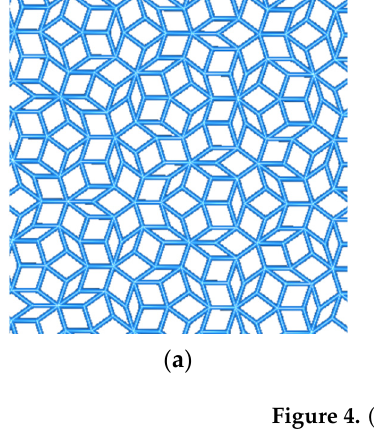
( b ) Figure 5. ( a ) Diffraction pattern of the Penrose tiling with monoatomic vertex decoration (all reflec- tions with n x – m y indices in a range − 12…12, 2300 atoms). ( b ) Reduced diffraction pattern of the Pen- rose tiling. The significant difference compared to the Fibonacci chain is now that the AUC con- sists of four pentagonal shapes (sum over 𝑗 in Equation (5)) labeled by component 𝑧 (cid:2884) .